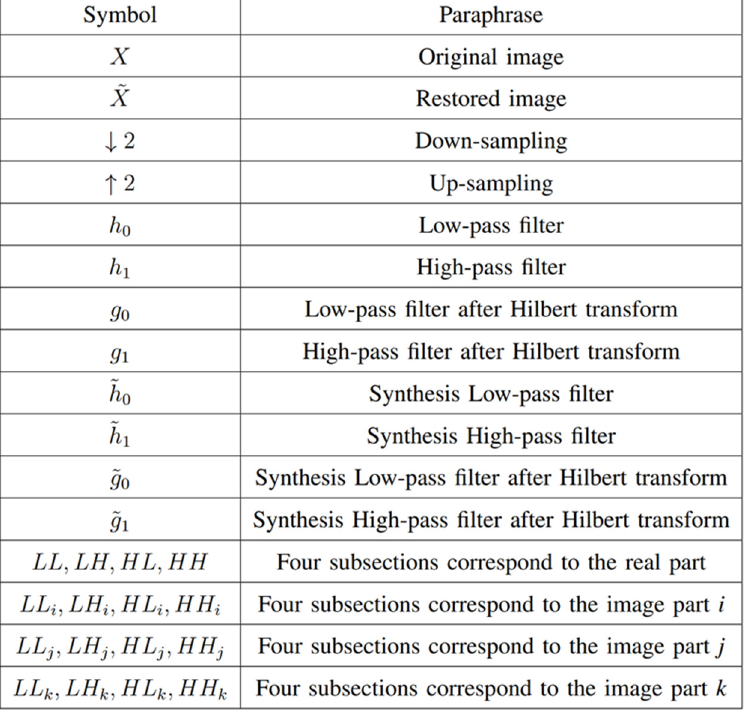
Figure 3. Symbols and meanings for QWT algorithm.